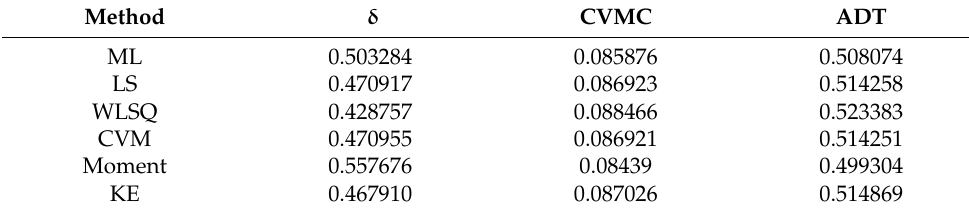
Table 4. p -values for comparing methods under the relief data.